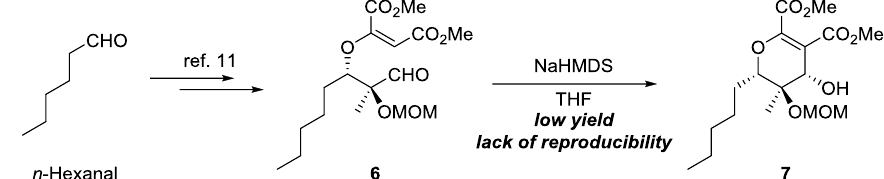
Table 1. Vinyl anion aldol reaction of aldehyde 6 .